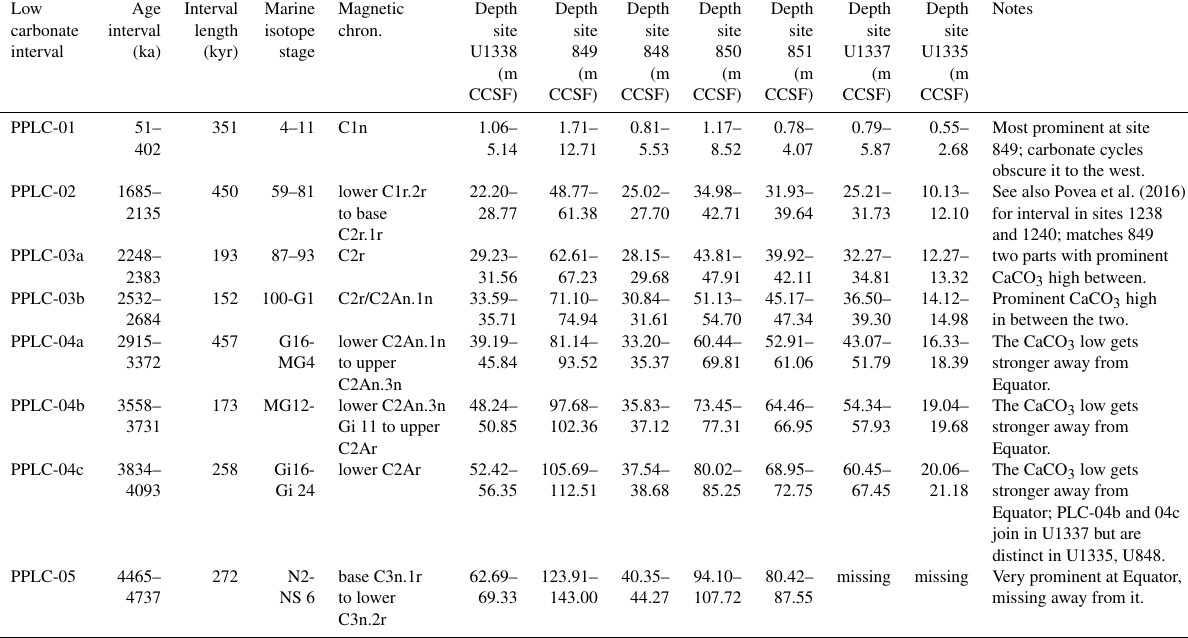
Table 2. Pliocene–Pleistocene low carbonate intervals